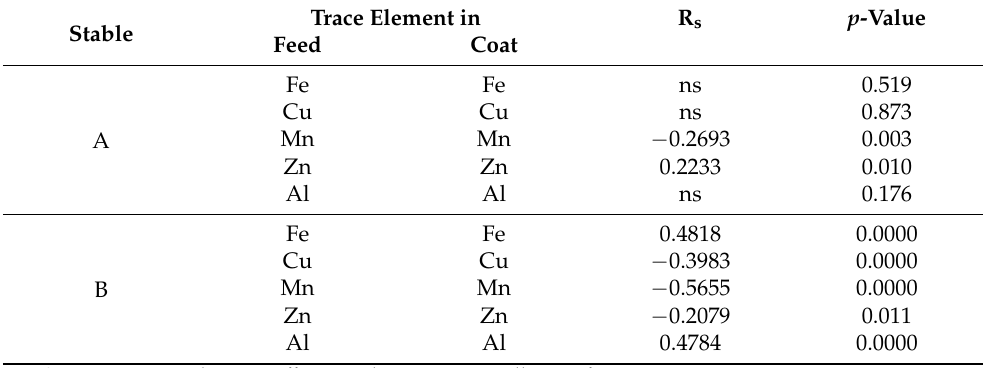
Table 4. Spearman rank correlation coefficient (R s ) and p -value of trace elements in feed and